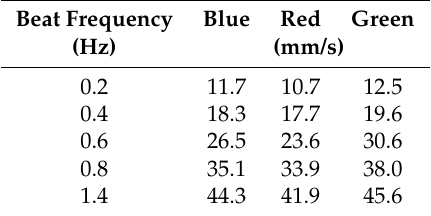
Table 1. Beat frequency effect on object speed.